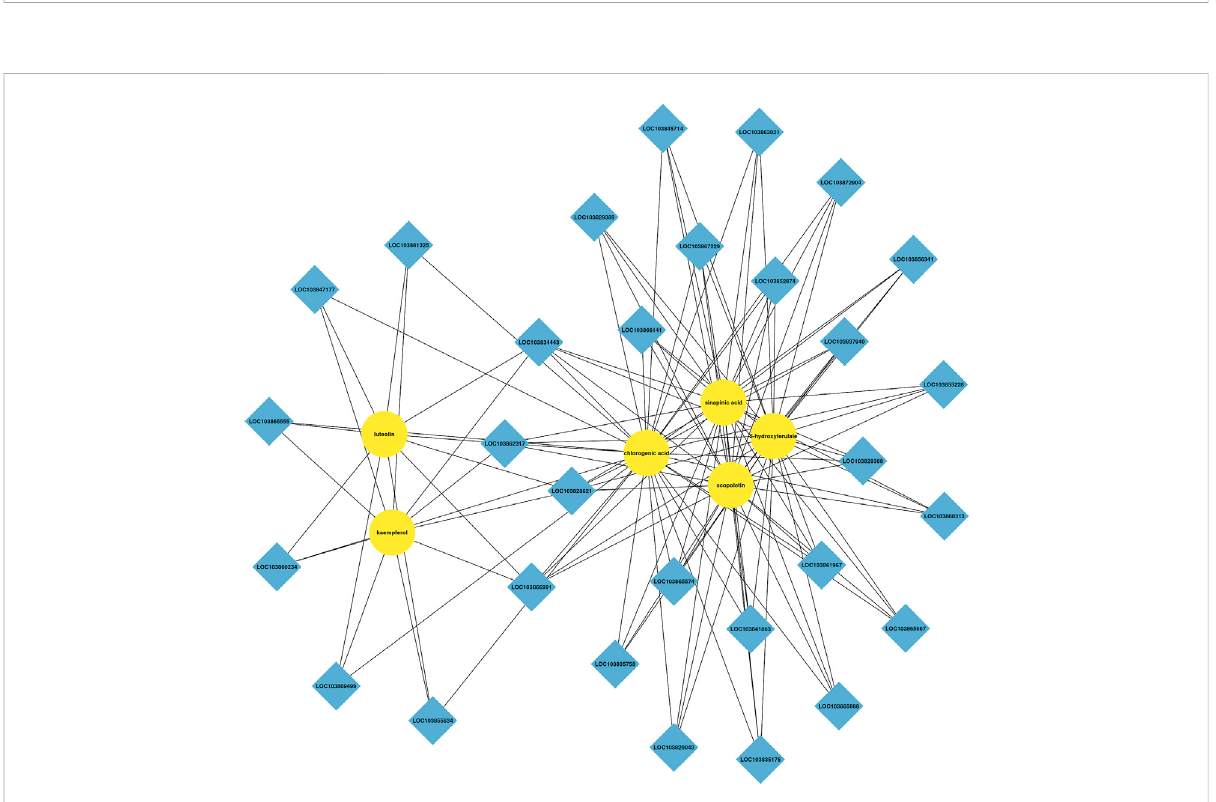
FIGURE 7 Connection network between differentially accumulated metabolites and related genes between the control and AR-Cd